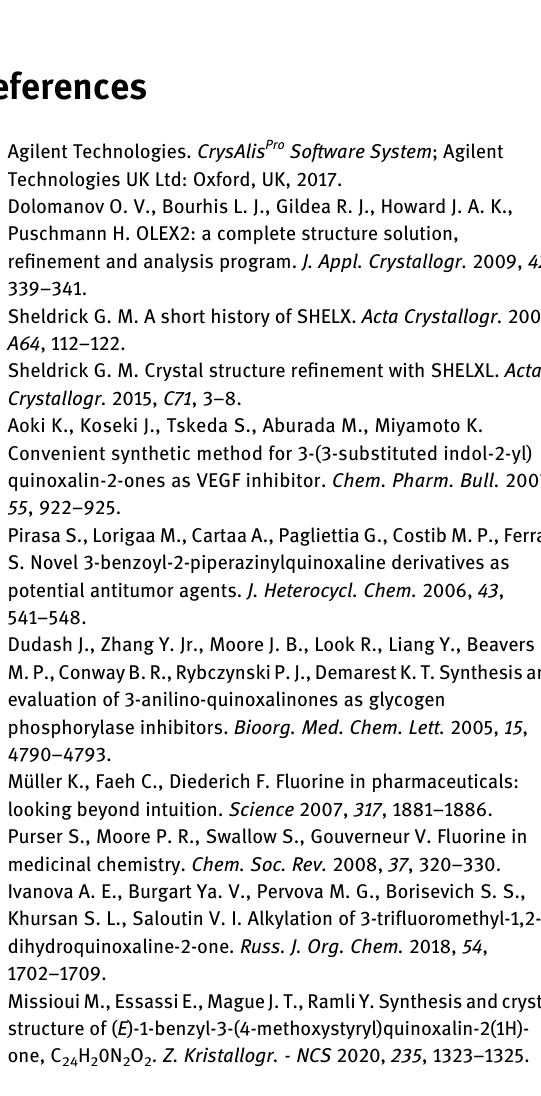
The asymmetric unit of the title structure contains two crystallographically independent but chemically identical molecules (cf. the figure). All bond lengths are in normal ranges [11]. The quinoxalin-2(1 H )-one ring in the structure is planar.